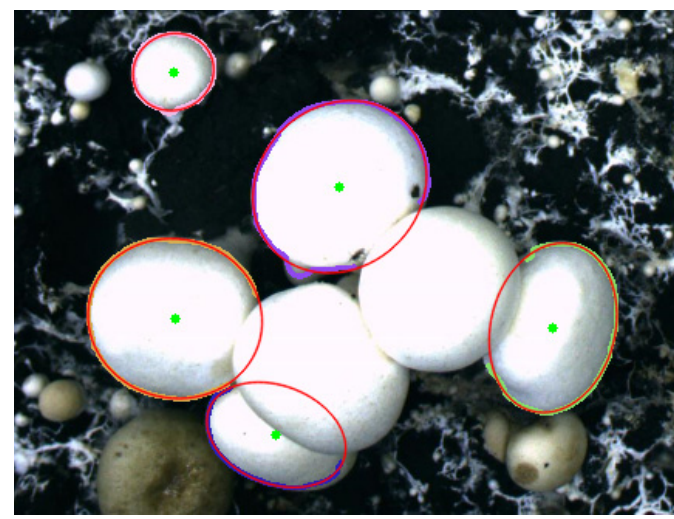
Figure 14. Oval profile of Agaricus bisporus.